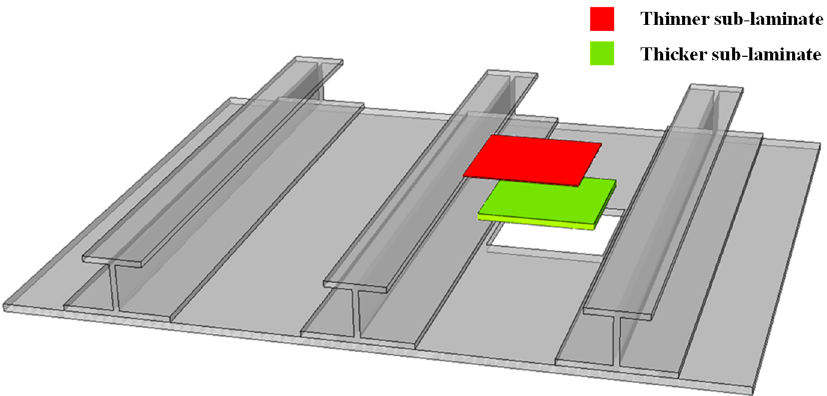
Figure 14. Details of global-local approach adopted in FE simulation.